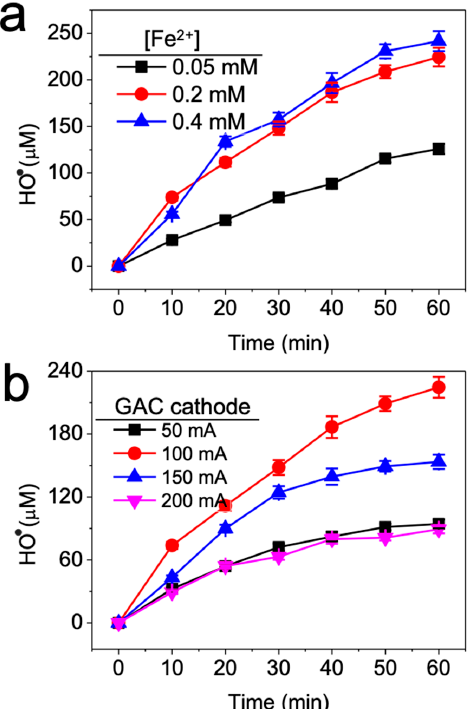
Figure 1. Impact of ( a ) ferrous iron ion concentration and ( b ) GAC cathode current intensity on hydroxyl radical generation during the electro-Fenton process. Conditions: ( a ) 3 g GAC as cathode under 100 mA current, pH ini 7; ( b ) 3 g GAC as cathode, 0.2 mM FeSO 4 , pH ini 7.